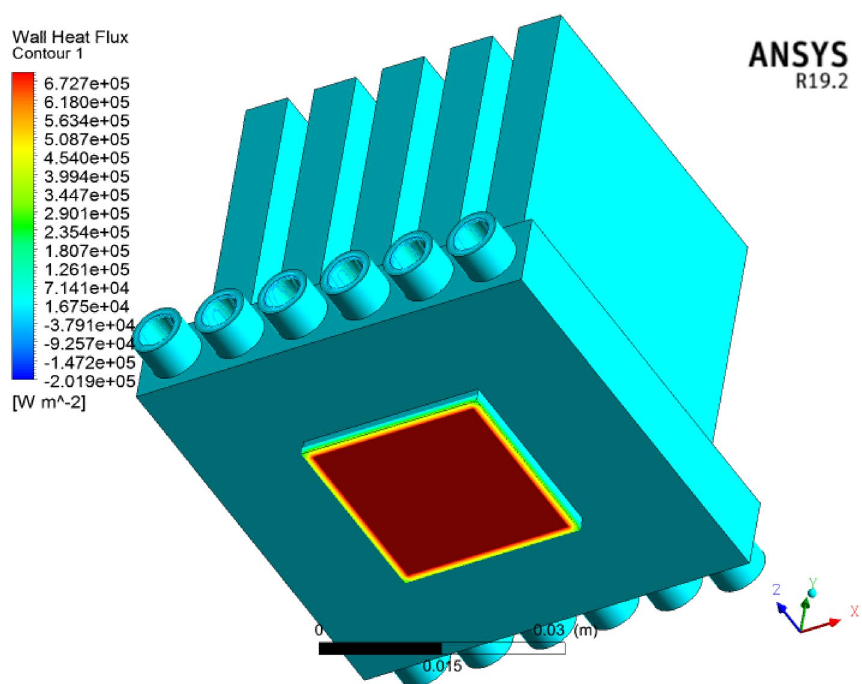
Figure 22. Wall heat flux significance for microelectronic chips in microchannel heat sinks with nanofluids by using